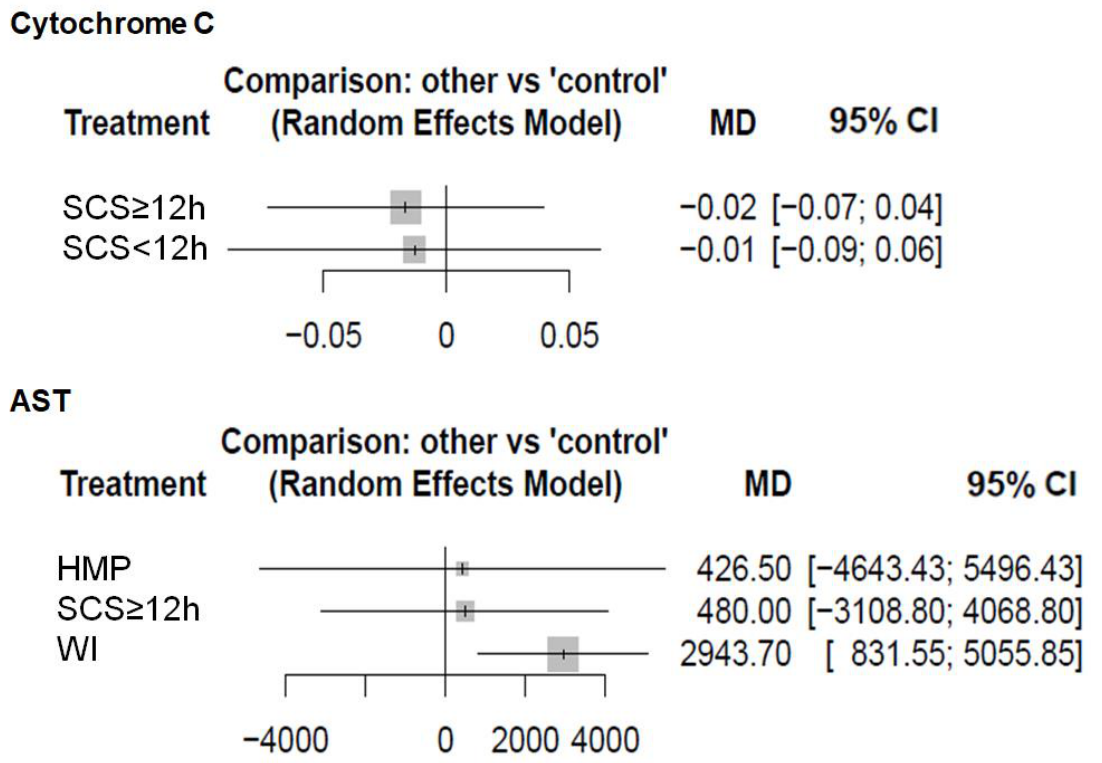
Figure 7. Comparison of cellular damage markers. Forest plot of mean differences (MD) compared to the control group. For all comparisons, the random effect analysis was used. AST: aspartate aminotransferase; SCS ≥ 12 h: static cold storage for over 12 h; SCS < 12 h: static cold storage for less than 12 h; WI: warm ischemia; HMP: hypothermic machine perfusion; CI: confidence interval.